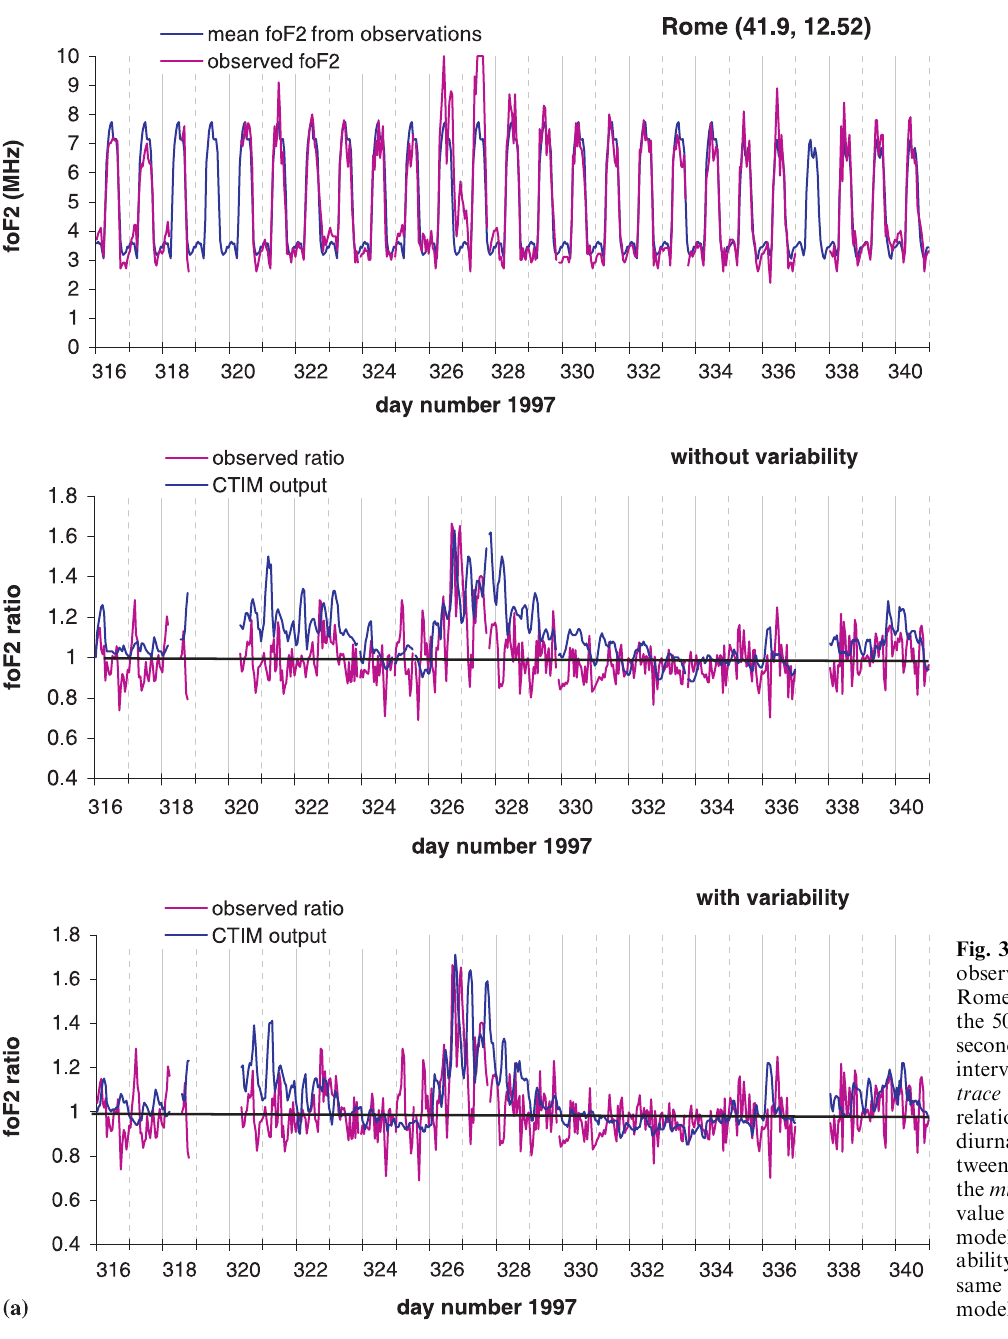
Fig. 3a, b. Comparison of the observed and modeled foF2 at Rome, for a the first 25 days of the 50-day interval, and b the second 25 days of the 50-day interval. In each case, the top trace shows the observed foF2 in relation to the mean monthly diurnal variation. The ratio be- tween these two traces is shown in the middle panel , together with the value extracted from the CTIM model simulations without vari- ability. The lower panel shows the same data in comparison with the model simulation